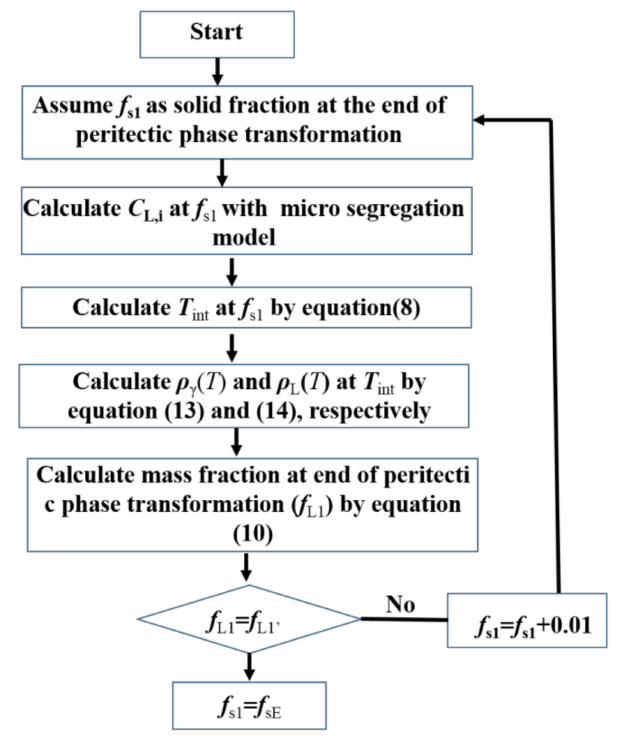
Figure 2. Flow chart for calculation of f s E